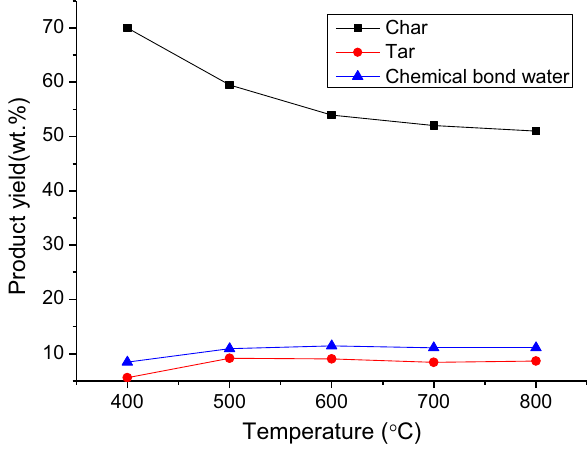
Fig. 6 Products yield during pyrolysis process of MZH coal, 10 (cid:3) C/ min, 1 bar